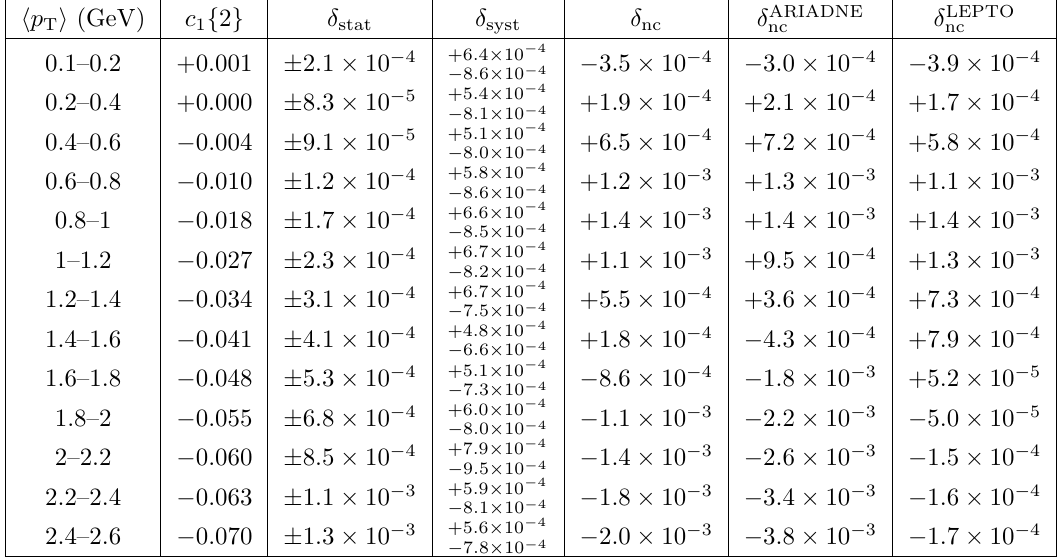
Table 22 . c 1 f 2 g versus h p T i from (cid:12)gure 9 (a), 5 (cid:20) N ch (cid:20) 10, p T > 0 : 1 GeV, j (cid:1) (cid:17) j > 2; (cid:14) stat , (cid:14) syst